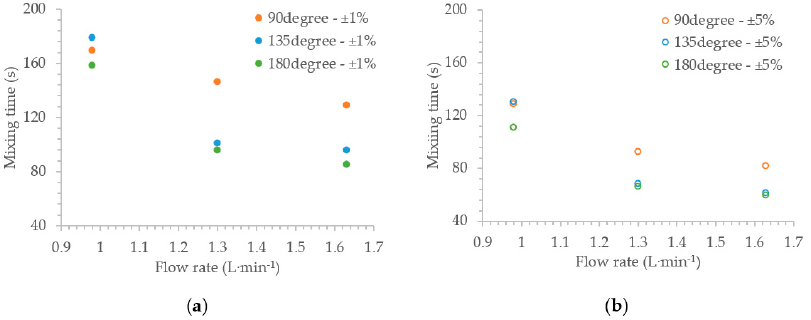
Figure 12. Measured mixing time with various radial-plug angles in the experiment: ( a ) ±5% homogenization and ( b ) ±1% homogenization.